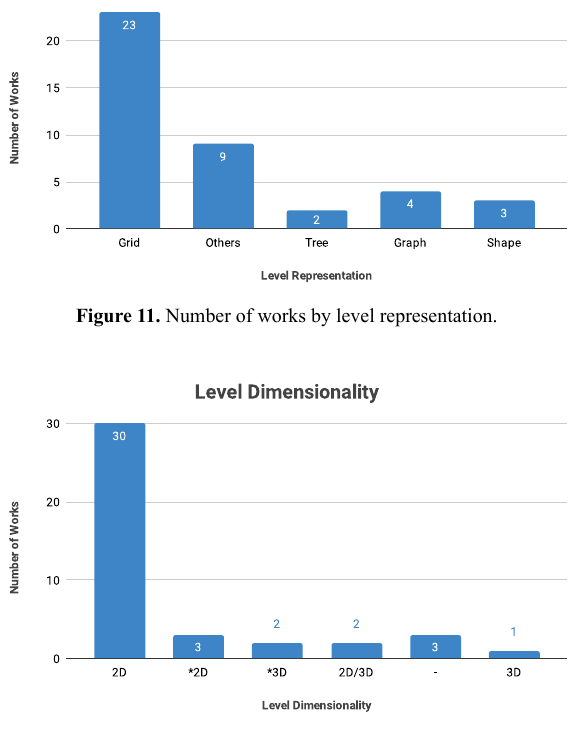
Figure 12. Number of works by level dimensionality. The ‘*’ occurrences mean that the work only performed a translation from a generated sketch to a level